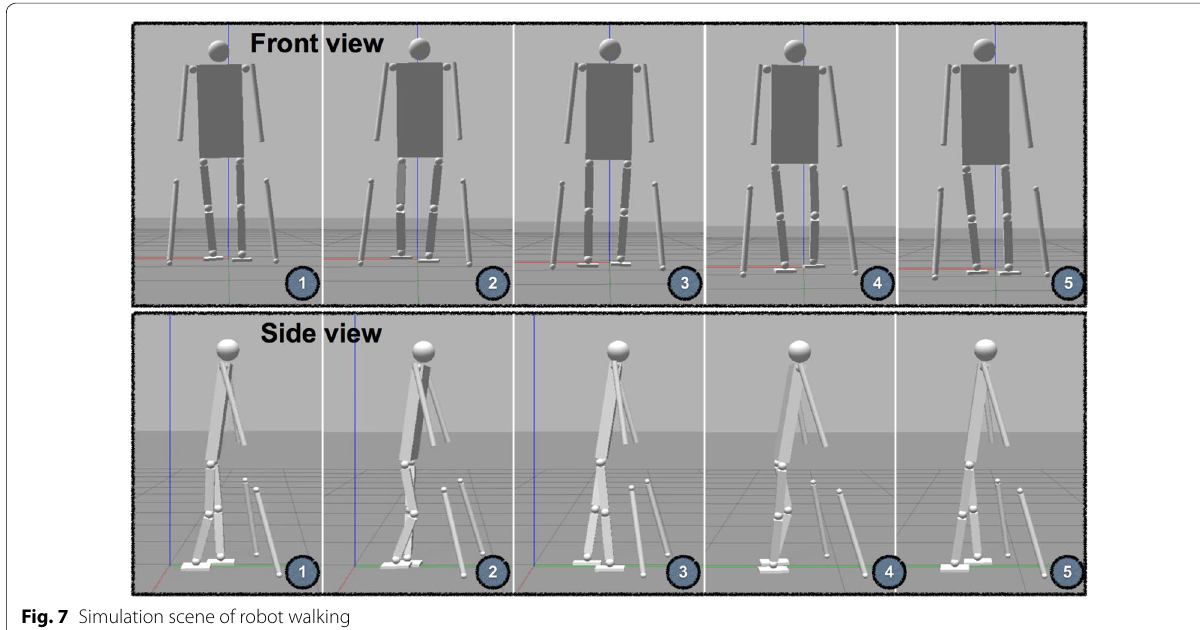
Fig. 7 Simulation scene of robot walking